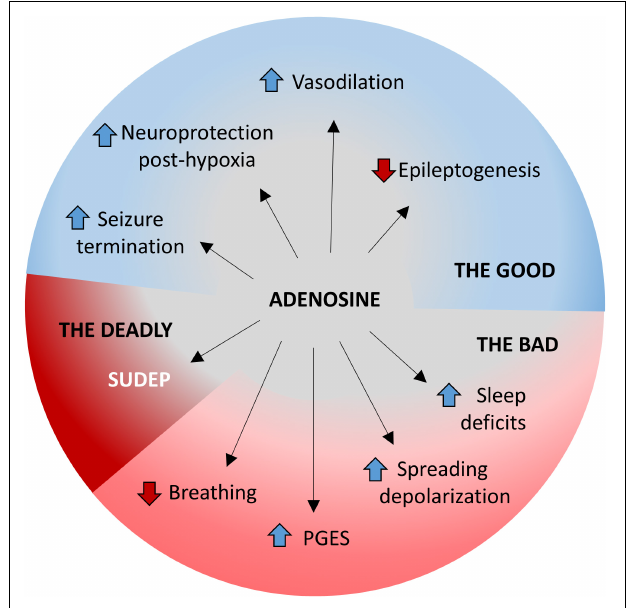
FIGURE 2 | The good, the bad, and the deadly effects of adenosine during seizures. The multifaceted roles of adenosine homeostasis during seizures is highlighted. The beneficial/good aspects include (i) seizure termination, (ii) neuroprotection against hypoxia, (iii) increased vasodilation, and (iv) prevention of epileptogenesis. The detrimental/bad aspects include (i) suppression of breathing, (ii) PGES, (iii) worsened electrographic dysfunction following spreading depolarization, and (iv) development of sleep deficits. Excessive adenosine release or insufficient adenosine clearance may result in a deadly outcome in the form of SUDEP.